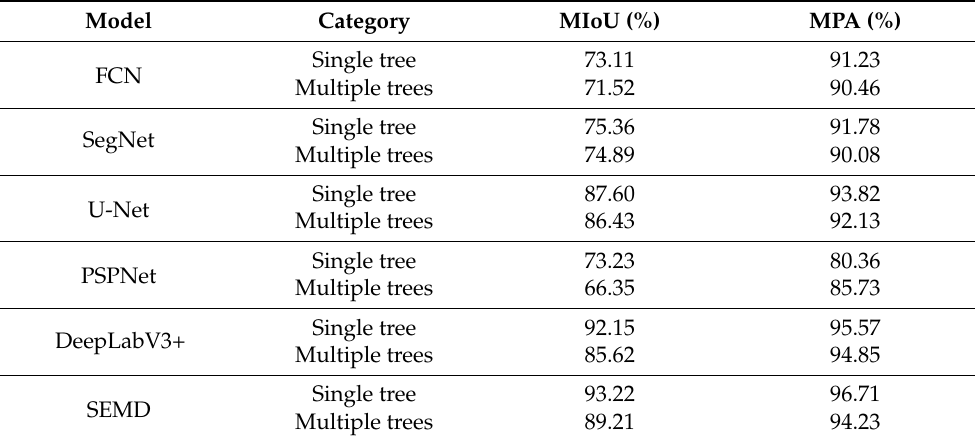
Table 5. Performance comparison in a simple